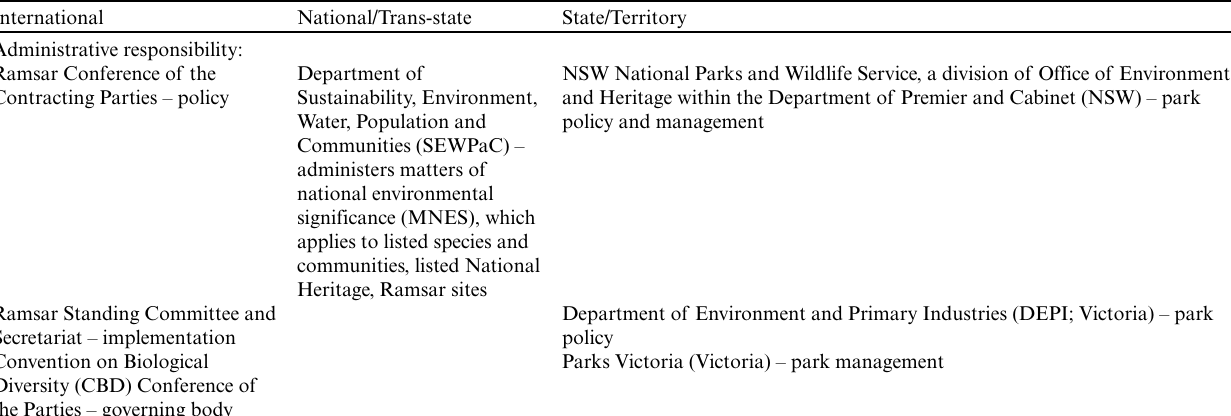
Table 2 . Governance features of the Alps focal region.